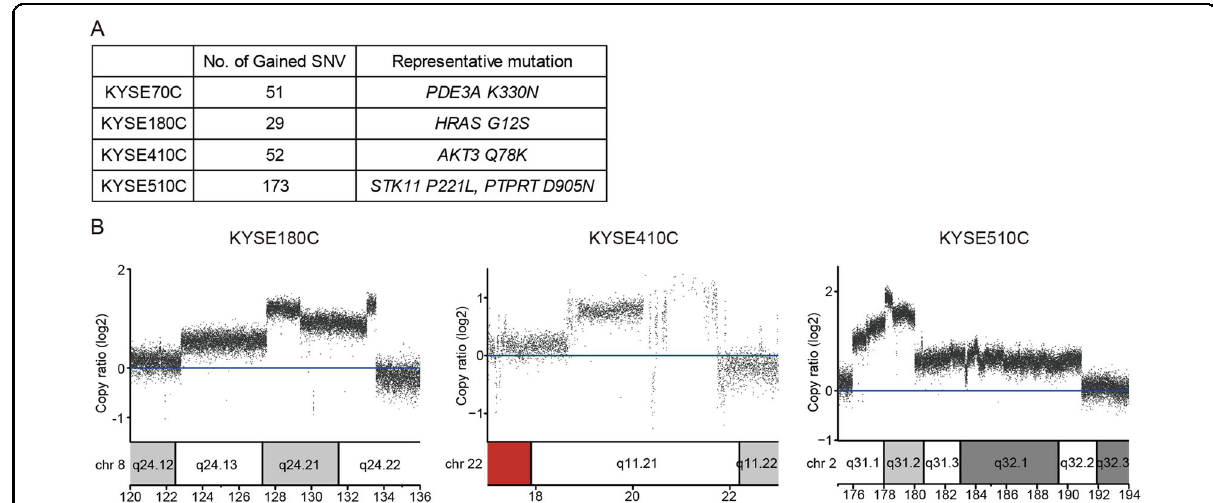
Fig. 2 Gained mutations and ampli fi cation of chromosome segments were detected in CYH33-resistant cells. Genomic DNA puri fi ed from KYSE70C, KYSE180C, KYSE410C, and KYSE510C cells and their parental cells was subjected to whole-genome sequencing. A Number of non- synonymous mutations and representative mutations in KYSE70C, KYSE180C, KYSE410C, and KYSE510C cells compared to their parental counterparts. B Ampli fi ed chromosome segments in KYSE180C, KYSE410C, and KYSE510C cells compared to parental